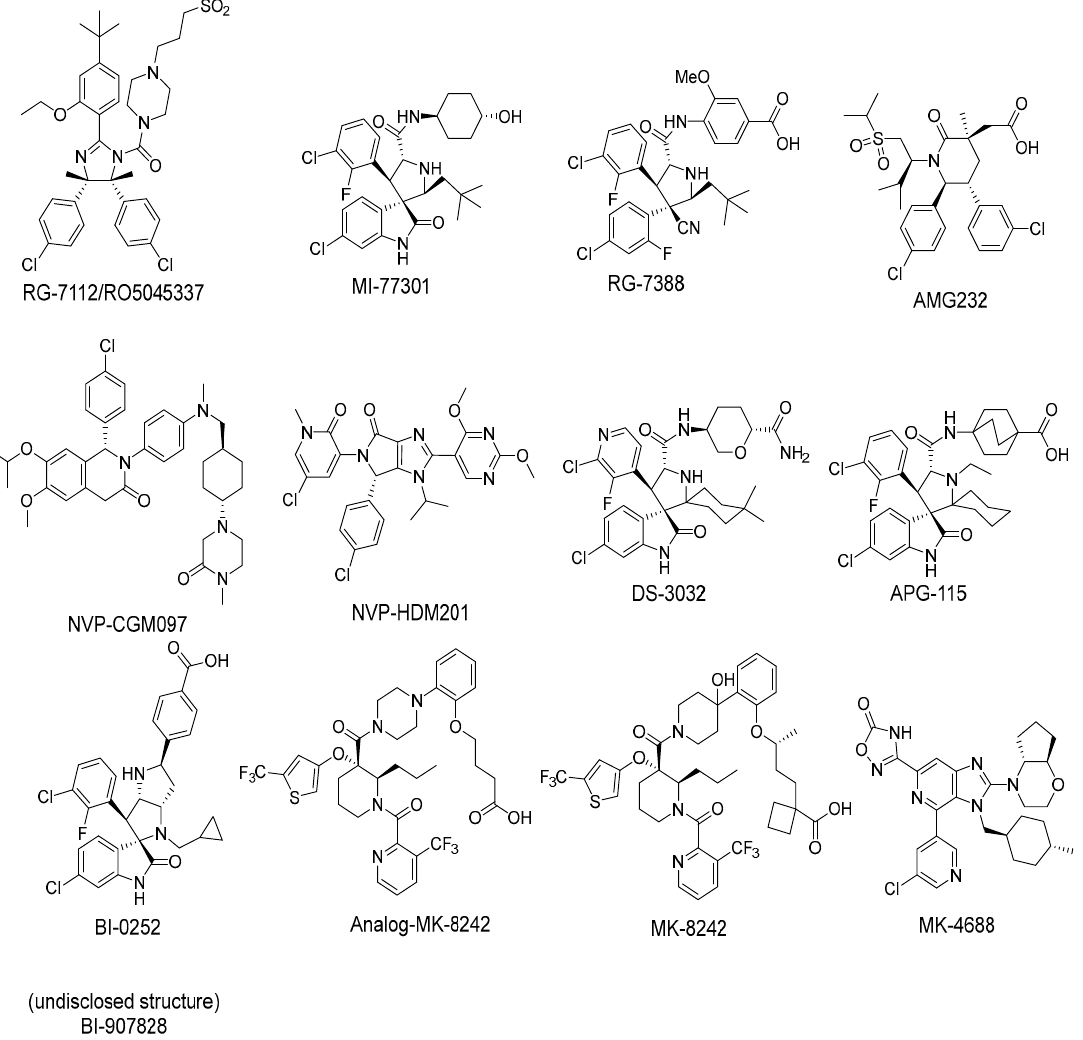
Figure 2. Chemical structure of MDM2 inhibitors.